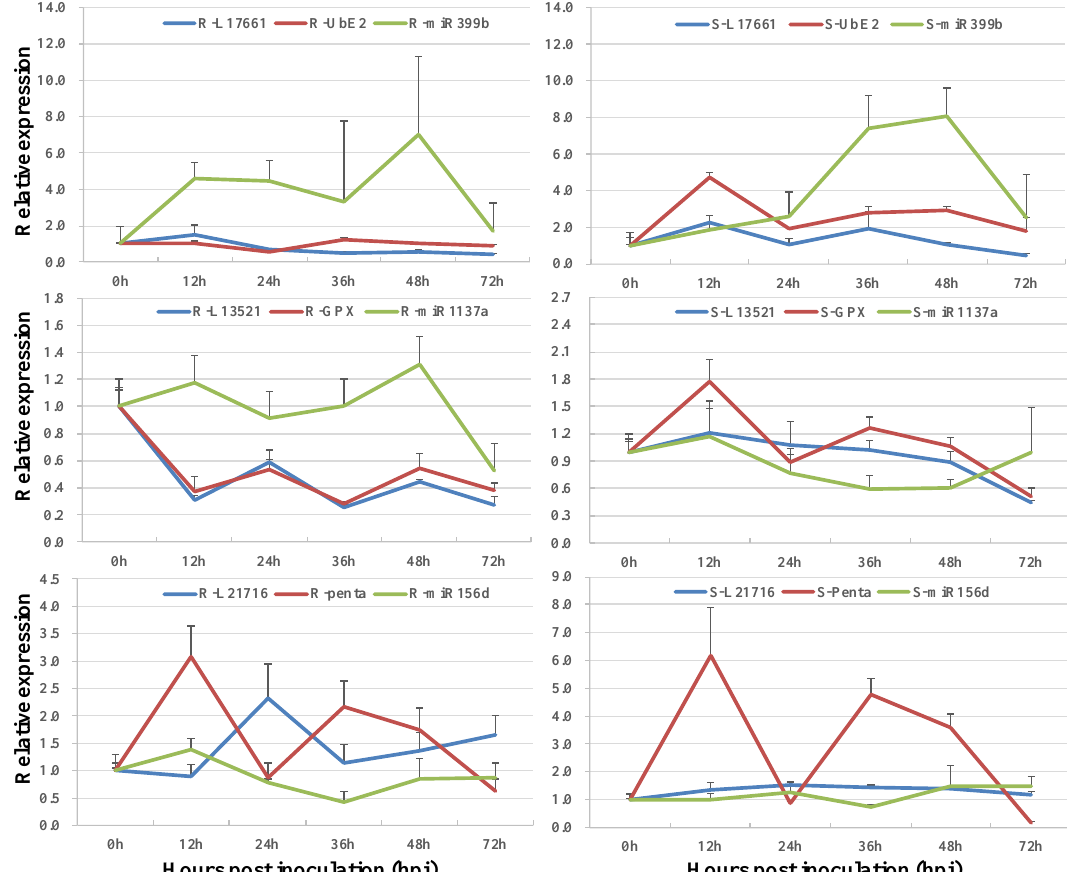
Figure 3. Expression patterns of lncRNAs, the functional genes and their paired miRNAs in N9134R and N9134S induced by powdery mildew infection at 0, 12, 24, 36, 48, and 72hpi. Gene expression levels were assessed by Q-PCR as aforementioned similarly. Blue lines represent the expression pattern of lncRNAs, while green and red lines represent the expression of miRNAs and its targeted functional genes, respectively.